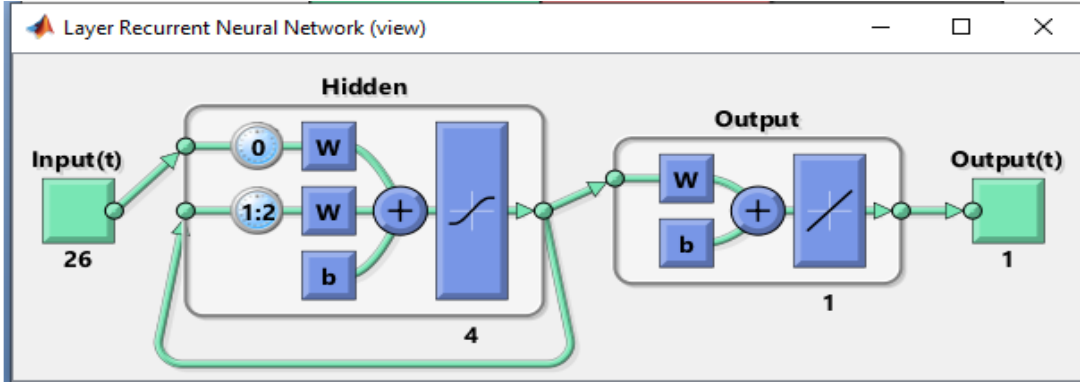
Figure 12. The RNN model as designed in the NN tool MATLAB.